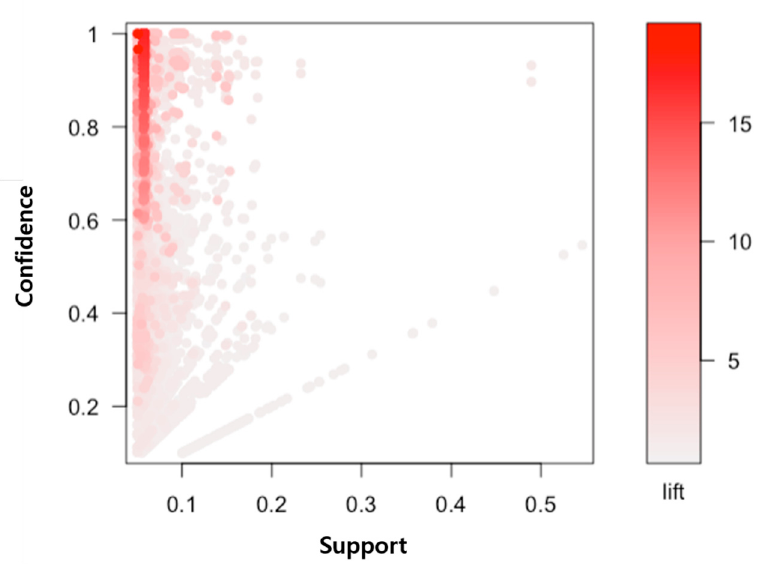
Figure 2. Association rules generated with the use of Stream Data (support 0.1, confidence 0.6).